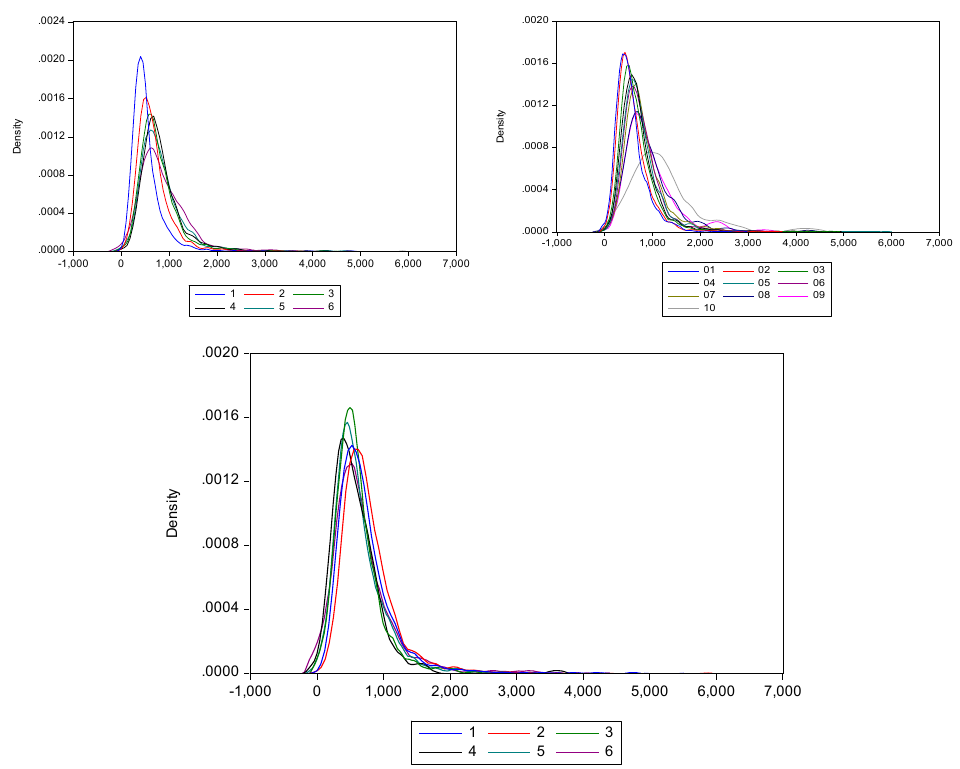
Figure 2. Electricity expenditure by household size ( up-left ), by family income ( up-right ) and by tenure regime ( down ). (The total electricity expenditure has been trunked to lower than 7000 to enhance the visualisation of the graph). Source: Own elaboration Kernel density using Family Budget Survey, 2016 (INE).